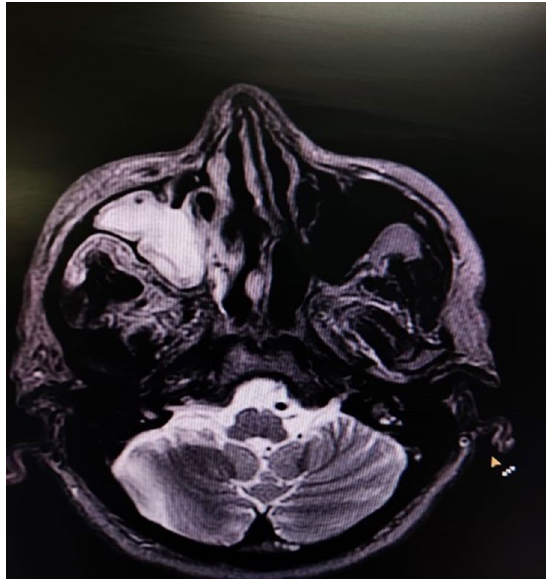
Fig. 1 Contrast-enhanced MRI scan of nose and paranasal sinuses of a patient showing opacification of right maxillary